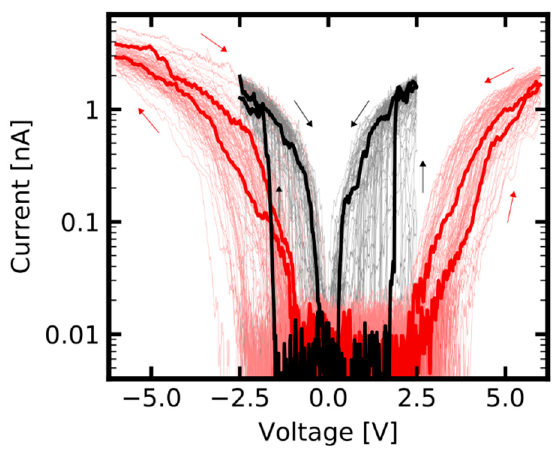
Figure 4. Electrical characteristic of an identical memtip operated over 50 cycles between − 2.5 V and +2.5 V on an Au counter electrode (black cycles), and over 50 cycles between − 6 V and +6 V on an ITO counter electrode (red cycles). Investigating an identical memtip allows the operation of the very same active filament on different counter electrode materials. For operation on ITO the switching window lies at higher voltages compared to operation on Au.